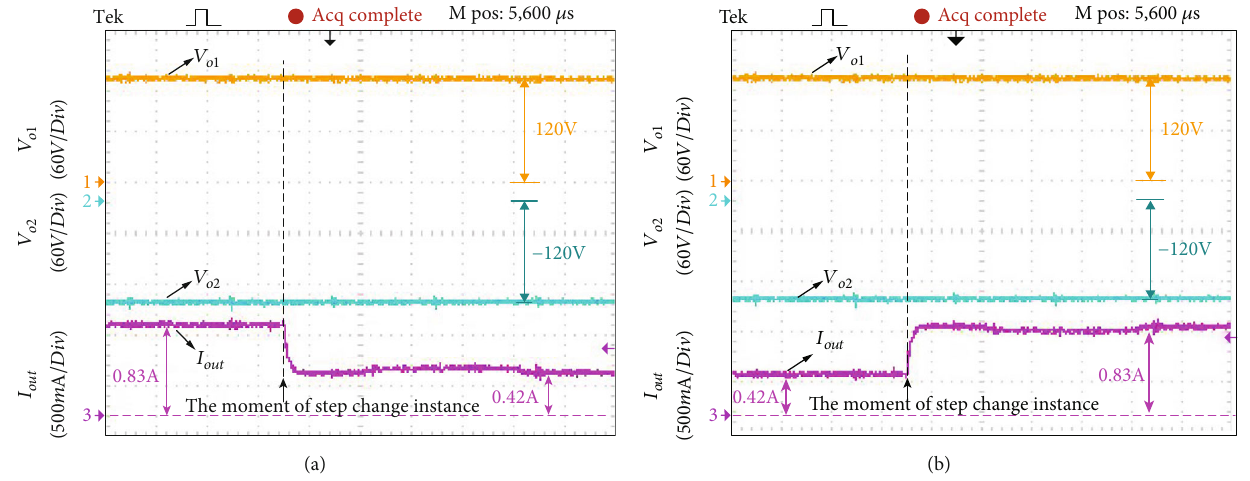
Figure 13: Sudden load change experiments: (a) sudden load increase and (b) sudden load